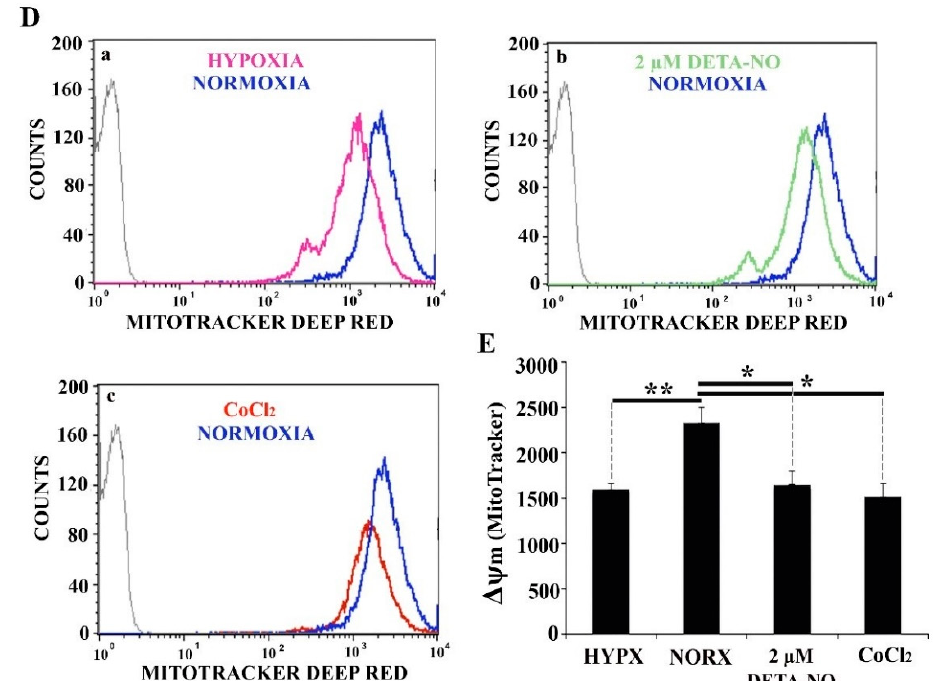
Figure 6. Exposure to 2 µ M DETA-NO decreases ∆ ψ m in normoxia. ( A ) Treatment with 2 µ M DETA- NO in normoxia induces a mitochondrial network distribution similar to hypoxia. Fluorescence microscopy of human iPSCs. MSUH-001 cells were cultured for 6 days in normoxia conditions and subsequently exposed for 48 h to either hypoxia or 2 µ M DETA-NO under normoxia. In another set of experiments, cells were exposed to CoCl2 for 4 h in normoxia. Then, cells were incubated for 30 min with MitoTracker Red and fixed in 4% PFA. Detection of nuclear morphology was determined by Hoechst (33342). Scale bar = 30 µ m. ( B ) Analysis of mRNA expression of mitochondrial fission markers DRP1 and FIS1. The plot shows the mean of the relative expression of 3 independent experiments ± SEM. ( C ) Analysis of the expression at mRNA level of mitochondrial fusion markers MFN1 and MFN2. The relative expression was calculated with the algorithm ∆∆ Ct. β -actin was measured as a housekeeping gene. (*) p < 0.05. ( D ) Analysis of changes in mitochondrial membrane potential ( ∆ ψ m) by flow cytometry following fluorescent staining with MitoTracker Deep Red. (a) Representative cytometry plot of cells cultured under hypoxia condition versus normoxia. (b) Representative cytometry plot of cells treated with low NO versus cells cultured in normoxia. (c) Representative cytometry plot of cells treated with CoCl 2 versus normoxia. ( E ) The bar graph represents the mean fluorescence intensity emitted in 6 independent experiments ± SEM. (*) p < 0.05: (**) p < 0.005. HIPX (HYPOXIA); NORX